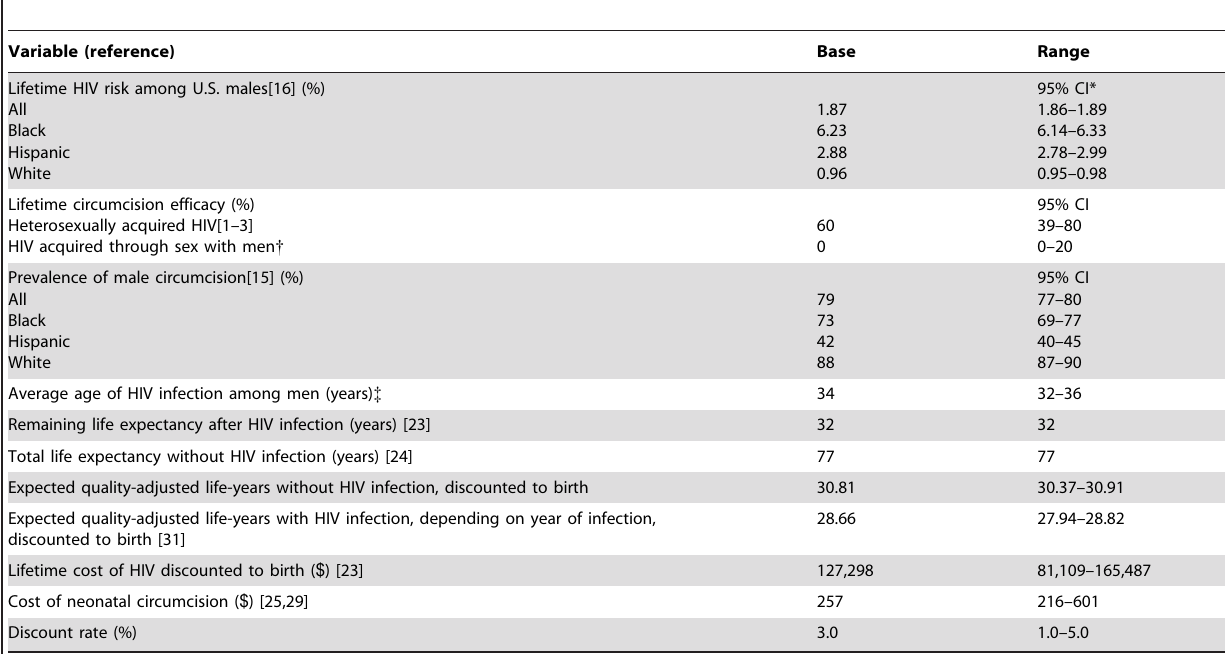
Table 1. Key parameters for assessing the cost-effectiveness of newborn circumcision in reducing lifetime HIV risk among U.S.